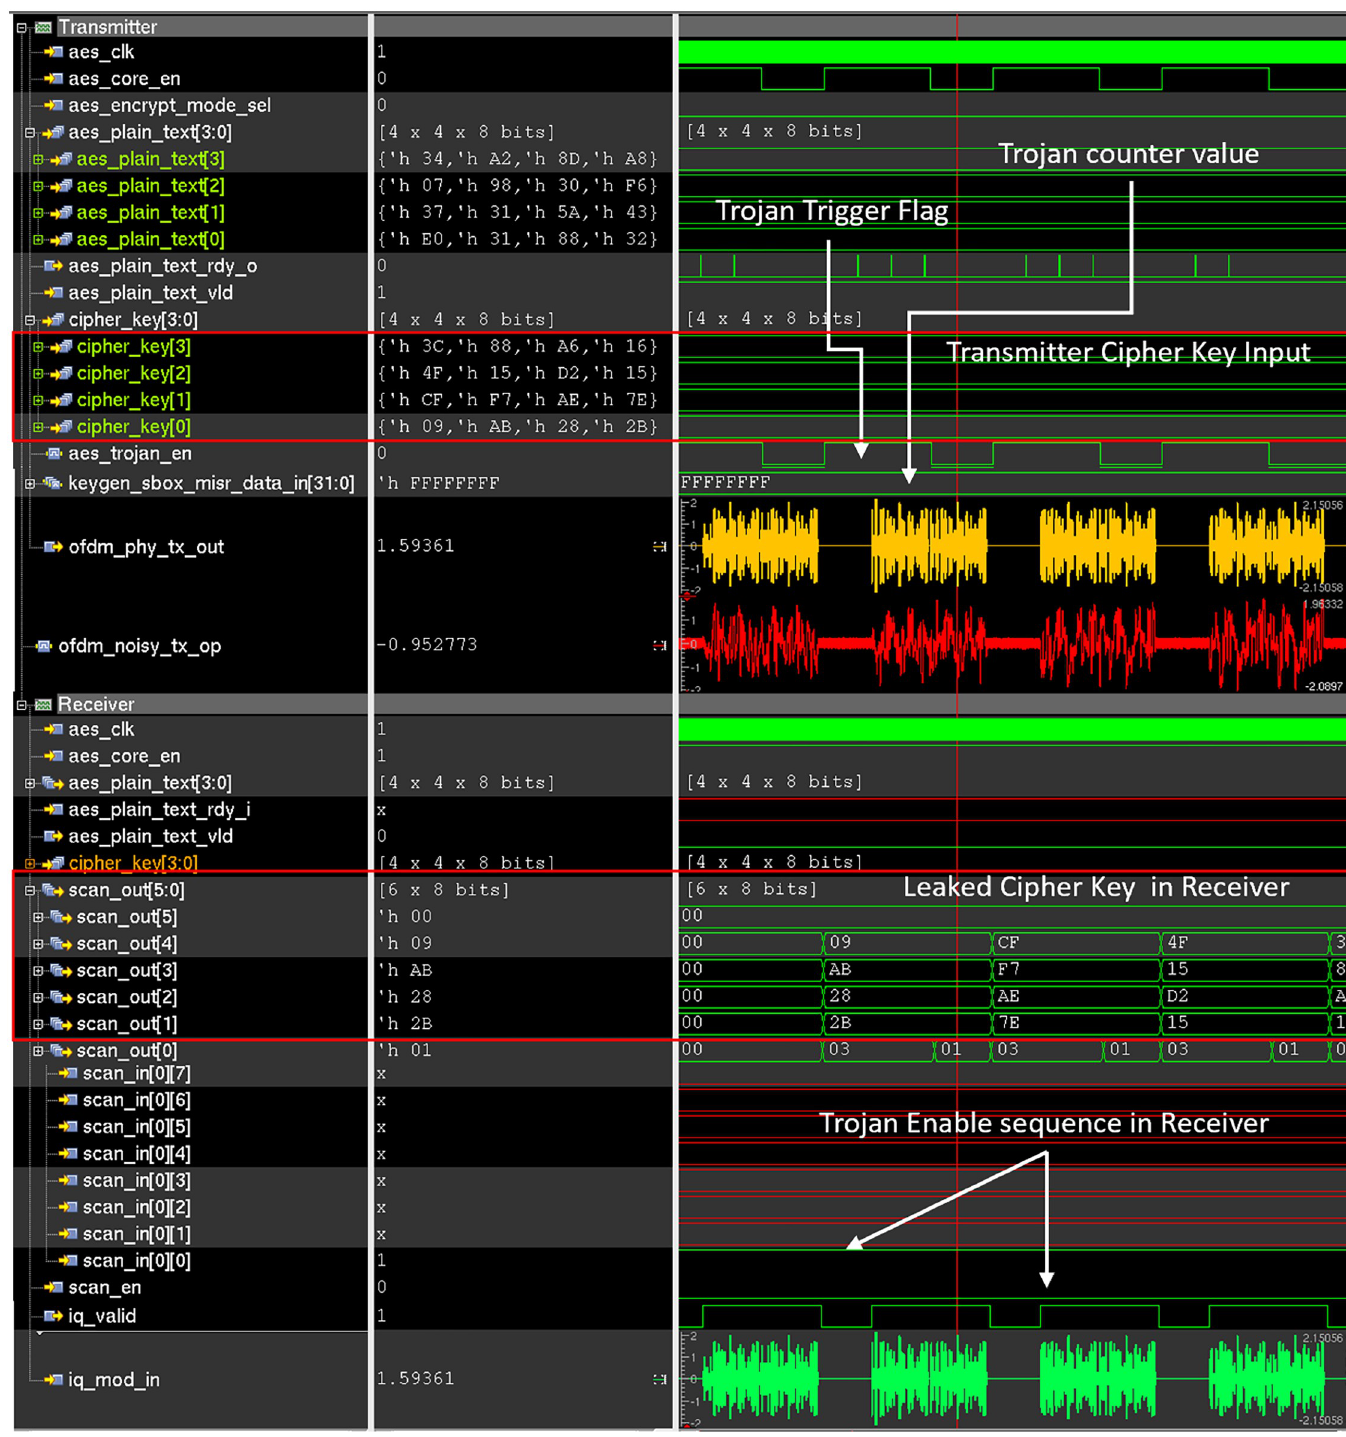
Fig 17. Simulation waveform of the trojan infested wireless cryptographic IC when HT is active.